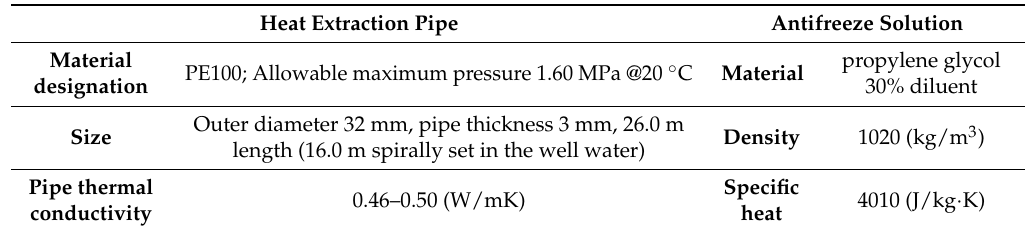
Table 2. Specifications of heat extraction pipe and antifreeze solution.